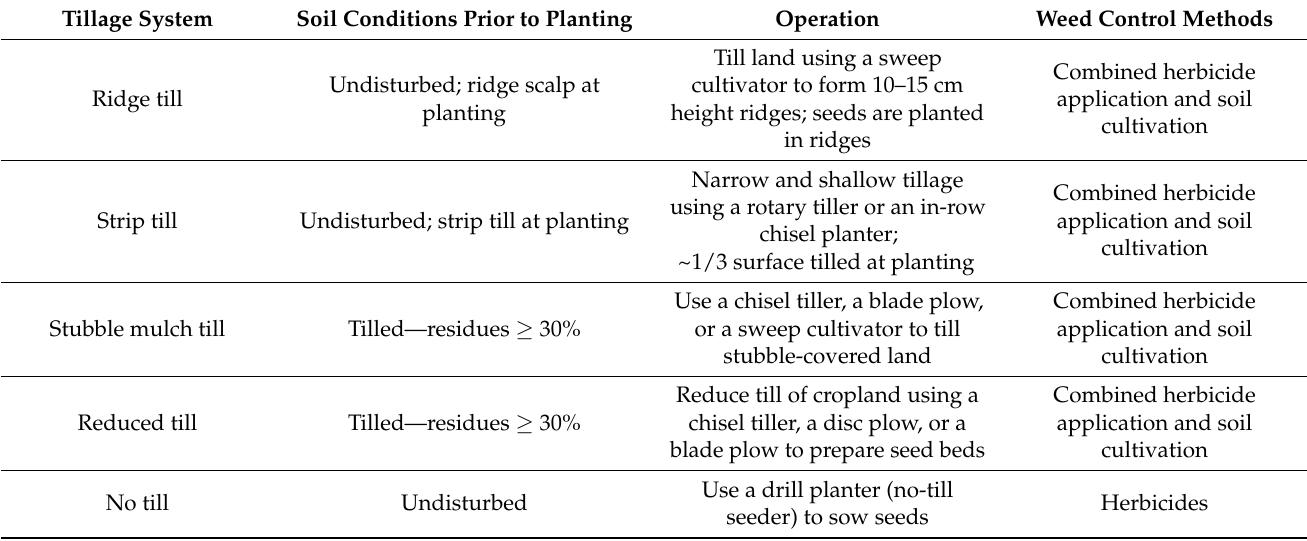
Table 3. Existing conservation tillage systems for controlling soil erosion and enhancing soil